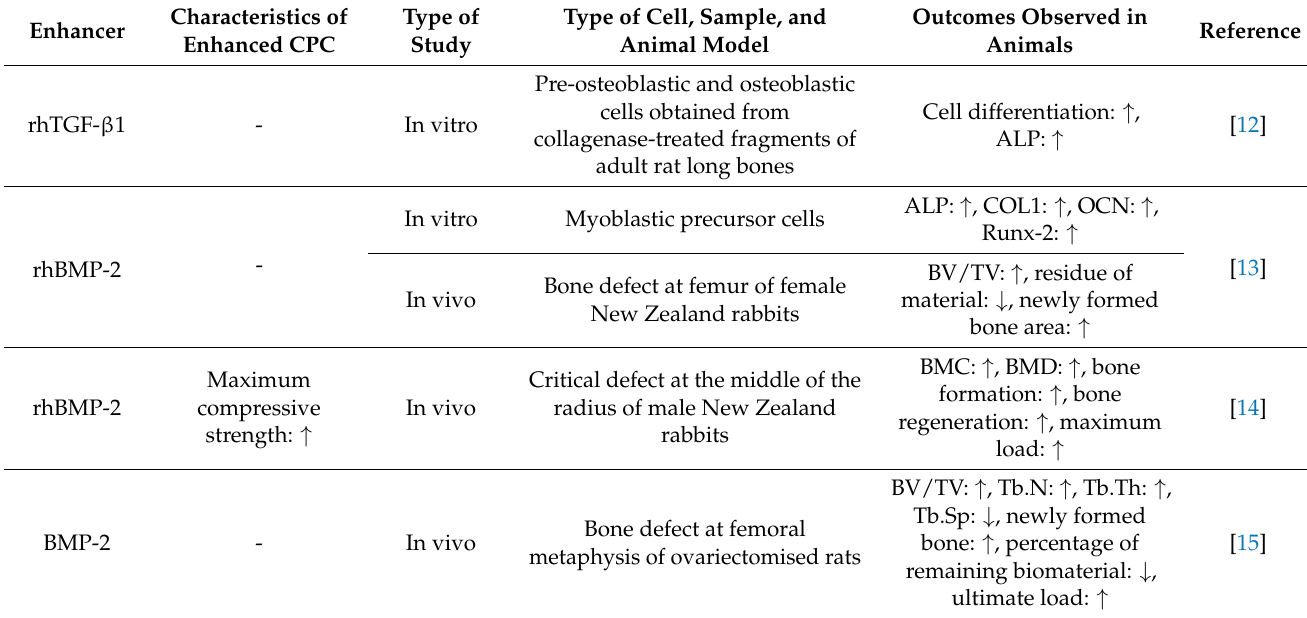
Table 2. The bone protecting effects of CPC enhanced by BMP-2 and TGF- β